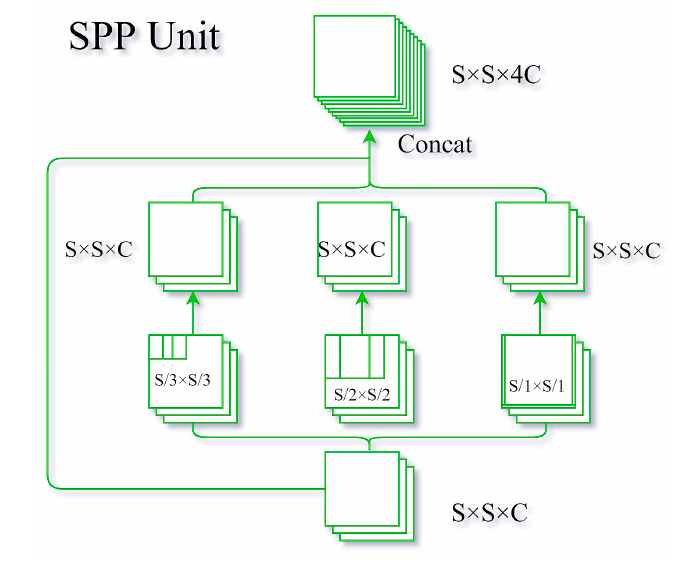
Figure 7. Improved SPP unit.